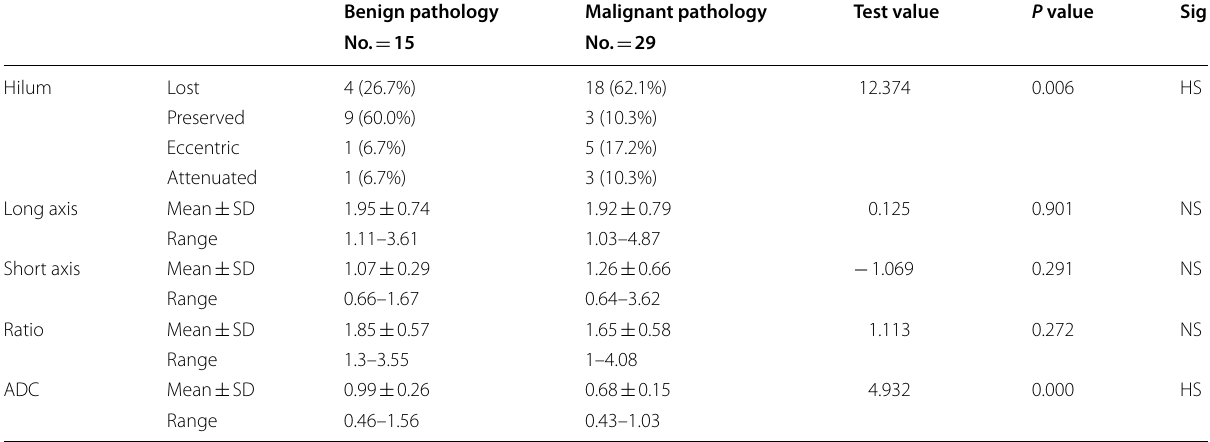
P value > 0.05: non-significant (NS); P value < 0.05: significant (S); P value < 0.01: highly significant (HS)